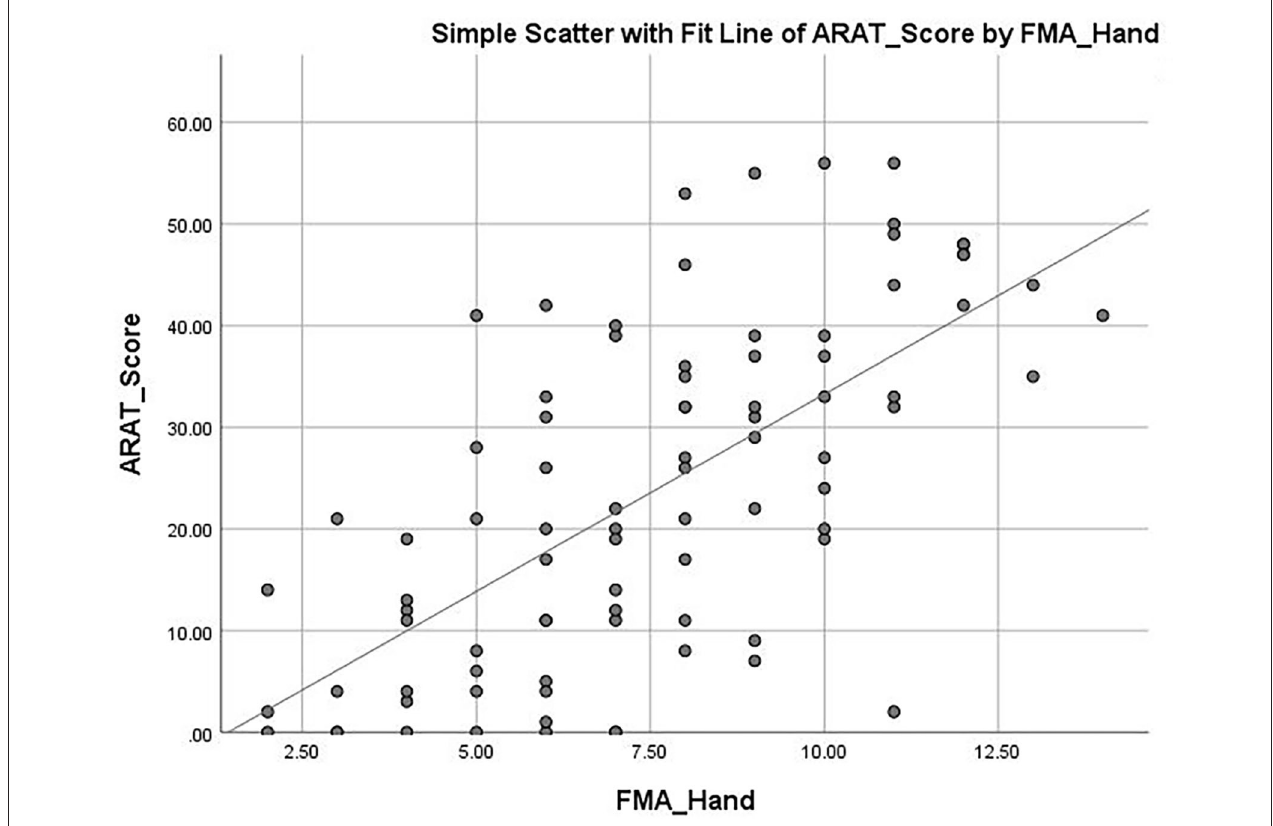
FIGURE 2 | The correlation between ARAT score and hand section of Fugl-Meyer Assessment